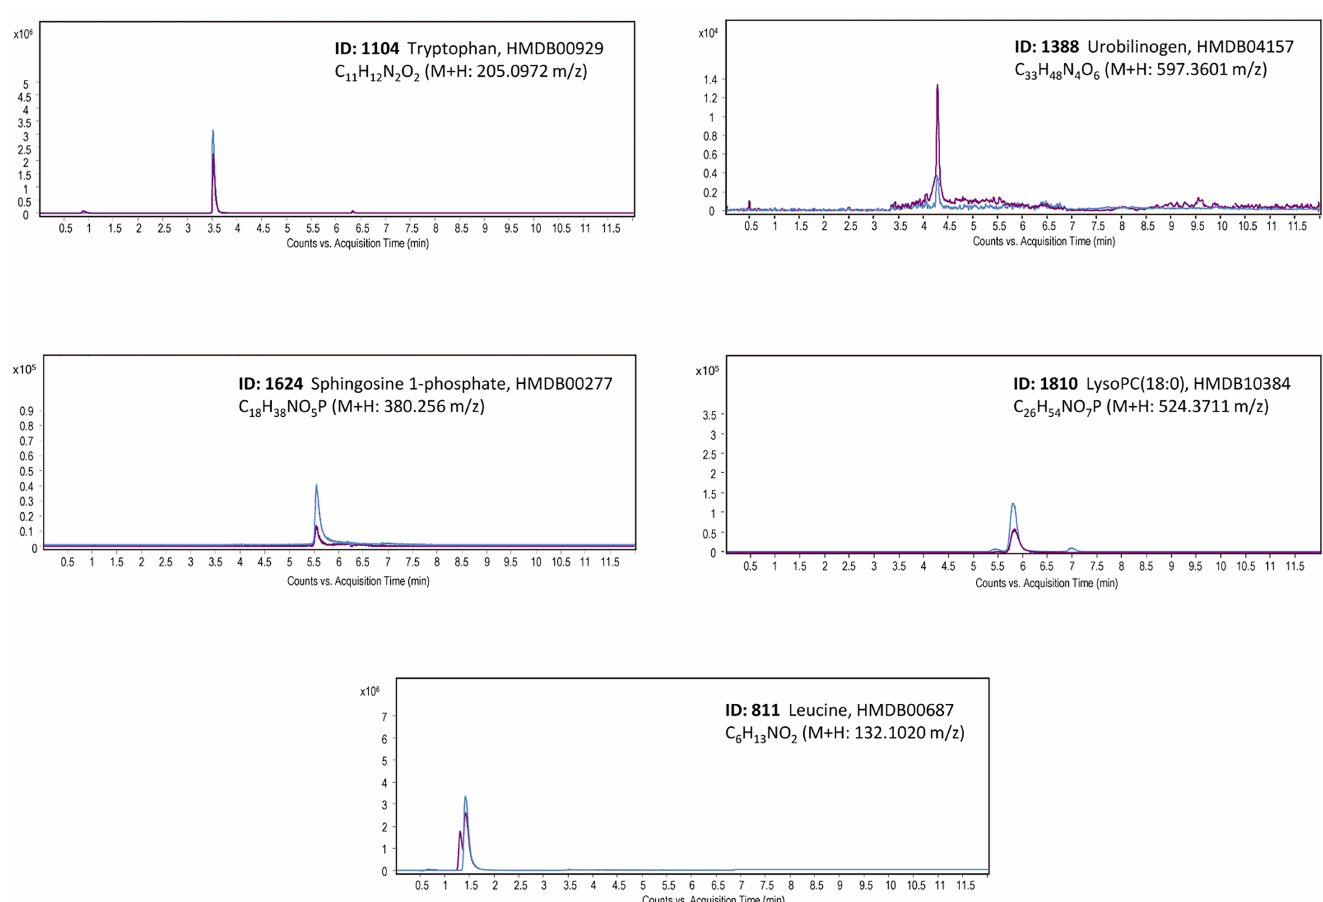
Fig 3. Identification of metabolites by co-elution with commercial standards. Extracted ion chromatograms of selectedmetabolites in plasma samples (purplelines) and commercial standards(blue lines)are shown. The metabolites are definedby their name, ID number, m/z (M+H), retention time, Human Metabolome Data Base ID numberand